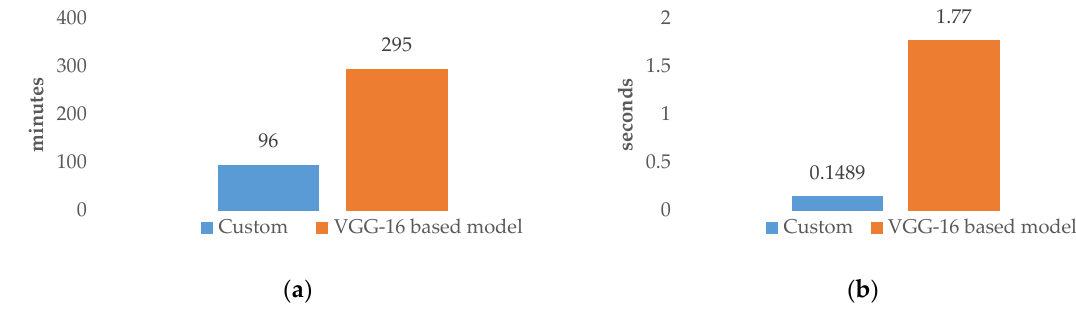
Figure 11. Time comparison between the custom model and transfer-learning-based model: ( a ) training time; ( b ) inference